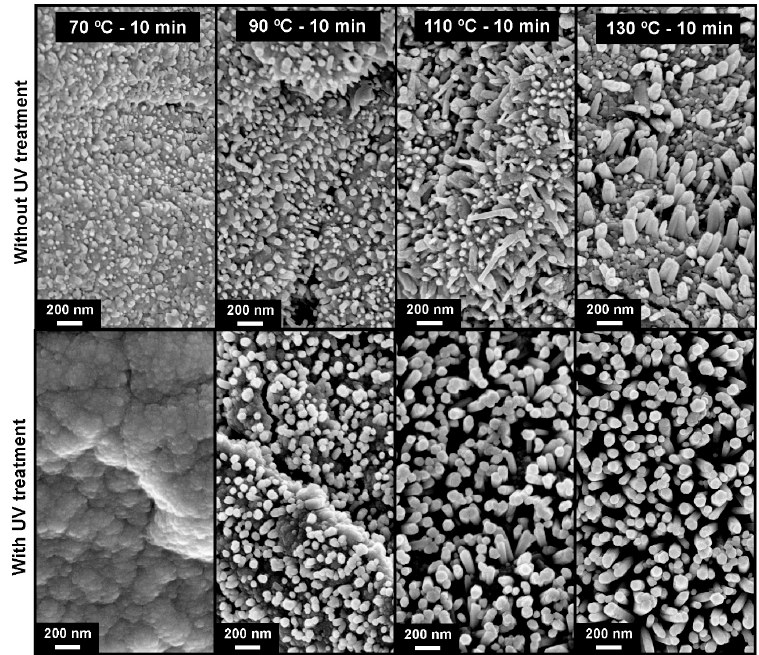
Figure 6. Surface SEM images of ZnO nanorods produced by hydrothermal method assisted by microwave irradiation on tracing paper, with a synthesis time of 10 min, with different synthesis temperatures (70, 90, 110 and 130 °C). On top are the images of samples produced without UV treatment and on the bottom samples produced with UV treatment.